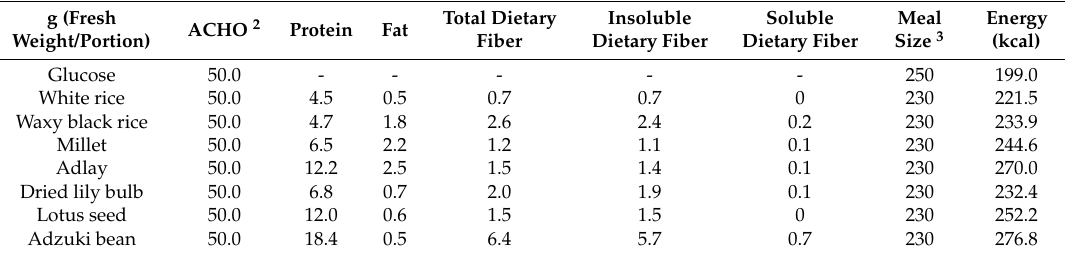
Table 1. Composition of test foods 1